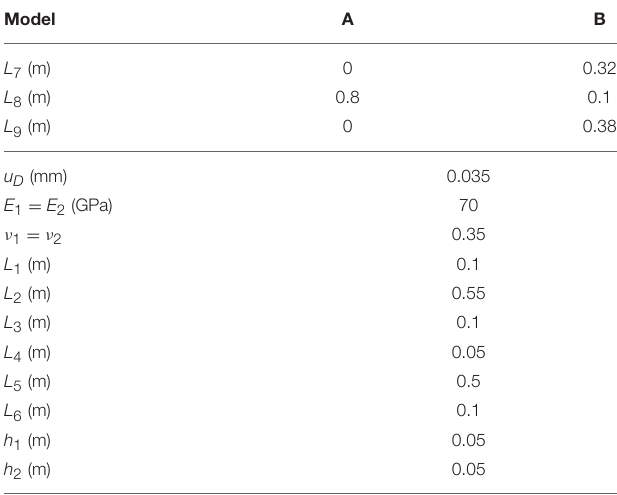
TABLE 3 | Geometry, elastic properties and the imposed displacements. Model